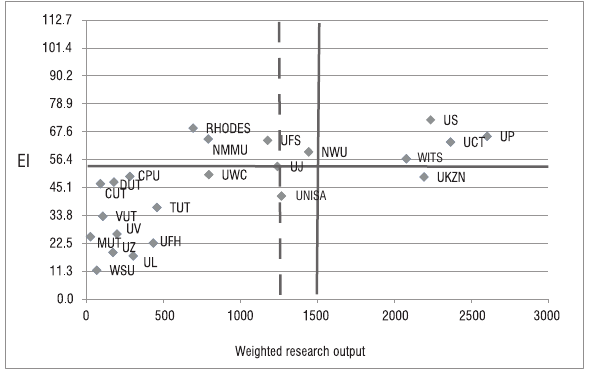
The 2011 per capita research output versus the instructional/ research professional staff Equity Index ( n